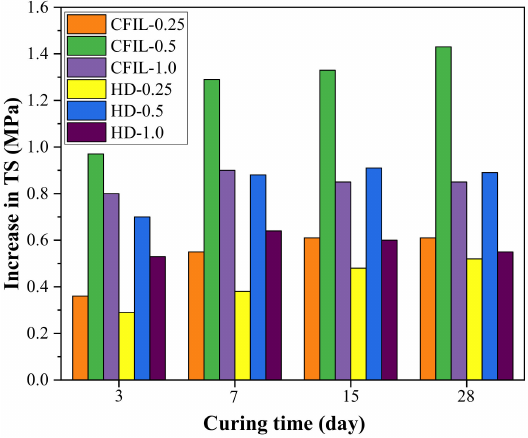
Figure 8. Increase in TS relative to NCH-0 for each experimental